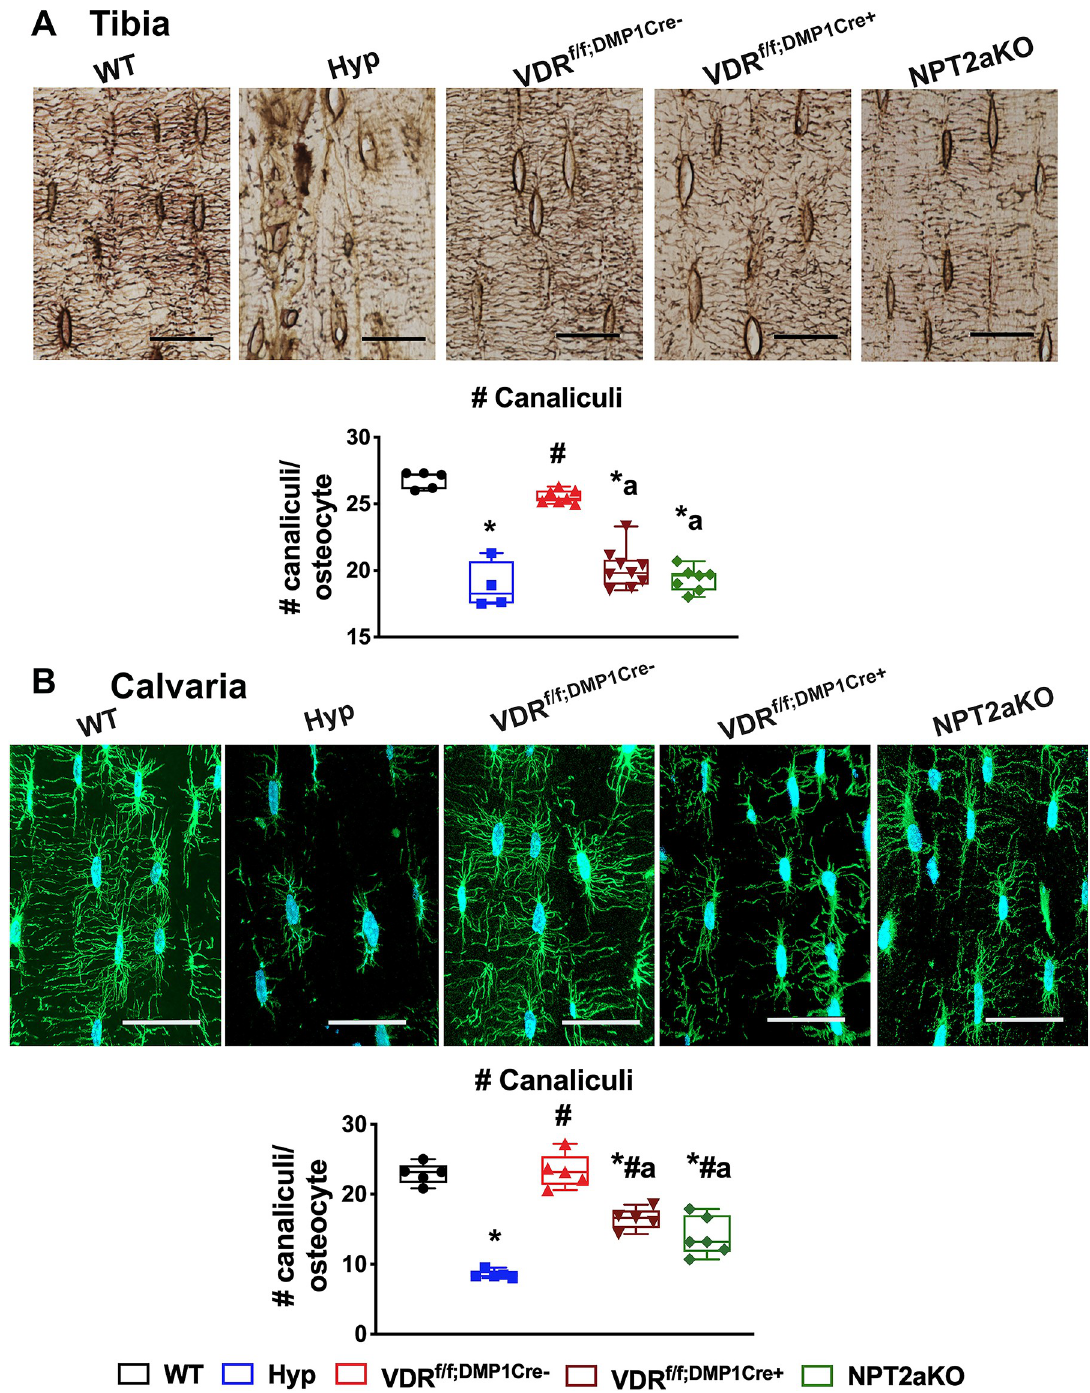
Fig 5. The tibial cortices of VDR f/f;DMP1Cre+ and NPT2aKO have impaired canalicular organization. (A) Silver stain of the canalicular network in d75 WT, Hyp, VDR f/f;DMP1Cre- , VDR f/f;DMP1Cre+ and NPT2aKO tibial cortices. Quantitation of number of canaliculi/osteocyte. Data are representative of that obtained from at least 5 mice per genotype, with WT and Hyp mice including 2–3 mice of either sex and all other groups including 3–5 mice of either sex. (B) Phalloidin stain of the canalicular network in d30 calvariae from WT, Hyp, VDR f/f;DMP1Cre- , VDR f/f;DMP1Cre+ and NPT2aKO mice. Number of canaliculi per osteocyte are quantified. Data are representative of that obtained from at least 5 mice per genotype, with each group including 2–3 mice of either sex. Scale bars = 20 μ m in (A) and (B). � p < 0.05 vs WT, # p < 0.05 vs Hyp, a p < 0.05 vs VDR f/f;DMP1Cre- , b p < 0.05 vs VDR f/f;DMP1Cre+ .